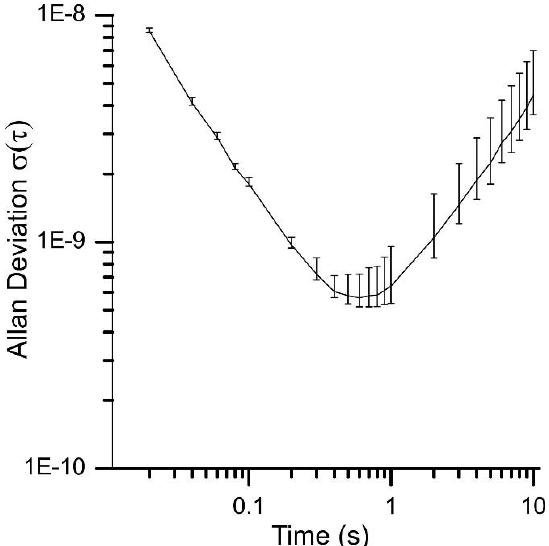
Figure 6. Allan deviation and errors of Quartz 1 just after the startup of the device (90% confidence interval).